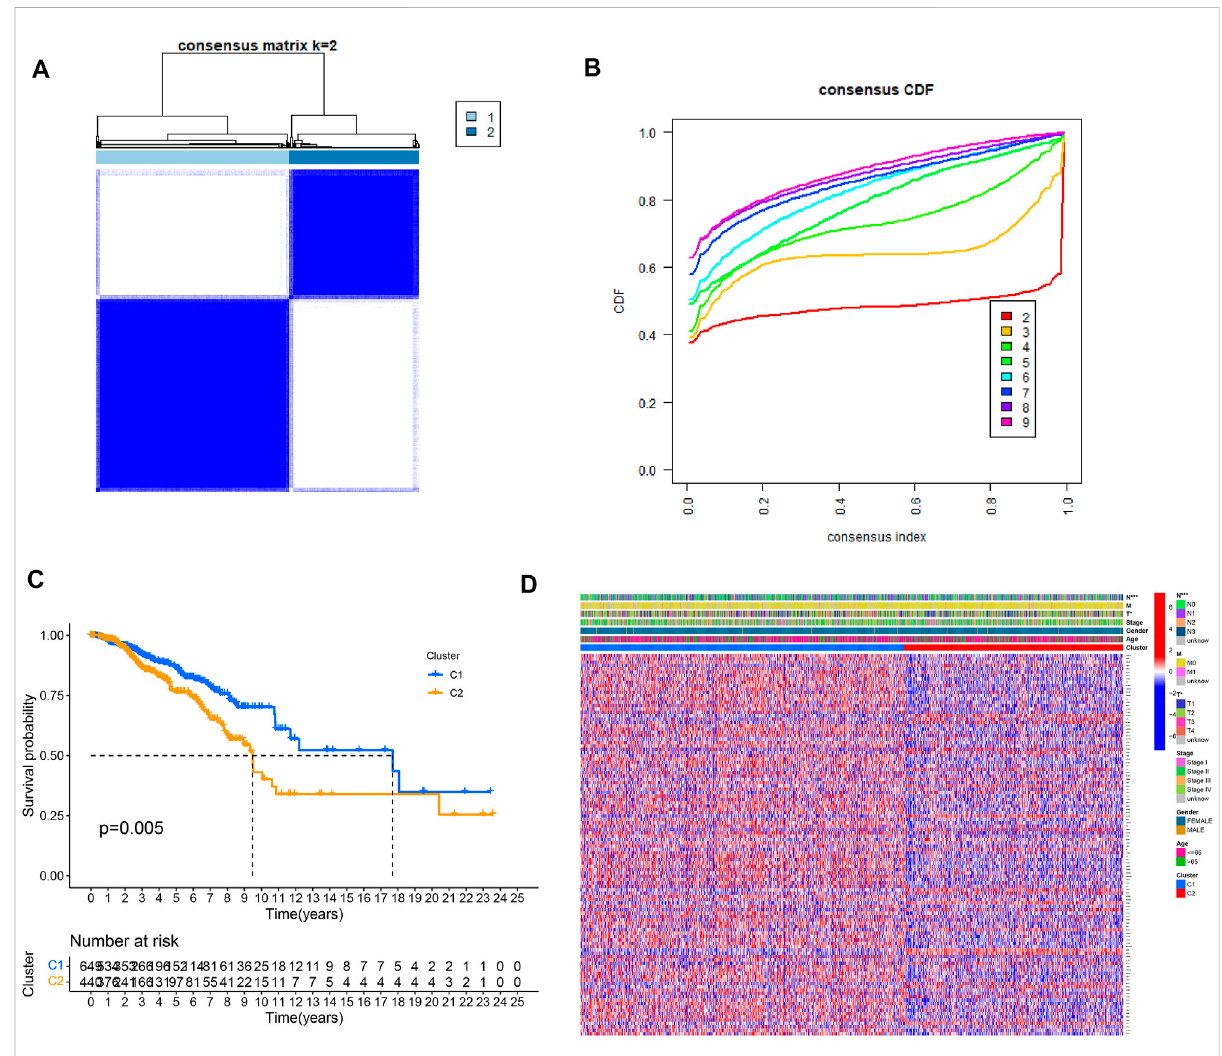
FIGURE 1 Clinical pathology and prognostic value of two distinct subtypes of patients divided by consistent clustering. (A) Consensus matrix heatmap de fi ning two clusters ( k = 2) and their correlation area. (B) Consensus CDF in consistent clustering ( k = 2 – 9). (C) Survival curve showing overall survival between C1 and C2. (D) Differences in clinical pathology features between the two clusters. C1, cluster 1; C2, cluster